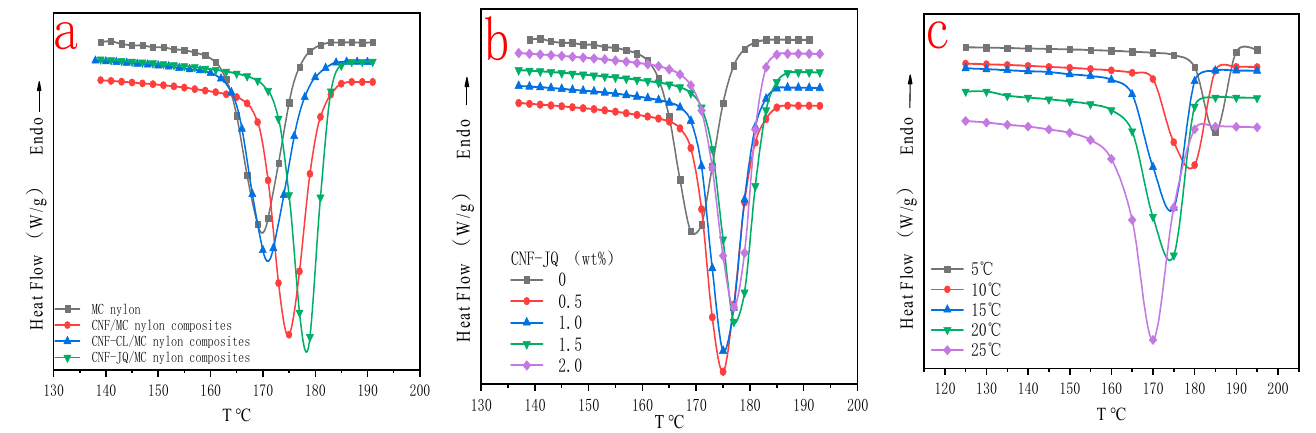
Figure 11. Temperature versus heat flow curves for MC nylon and its composites (( a ) for different modified CNF at a cooling rate of 10 °C with 1.0 wt% filler; ( b ) for different CNF–JQ additions at a cooling rate of 10 °C; ( c ) for different cooling rate curves at 1.0 wt% CNF–JQ).